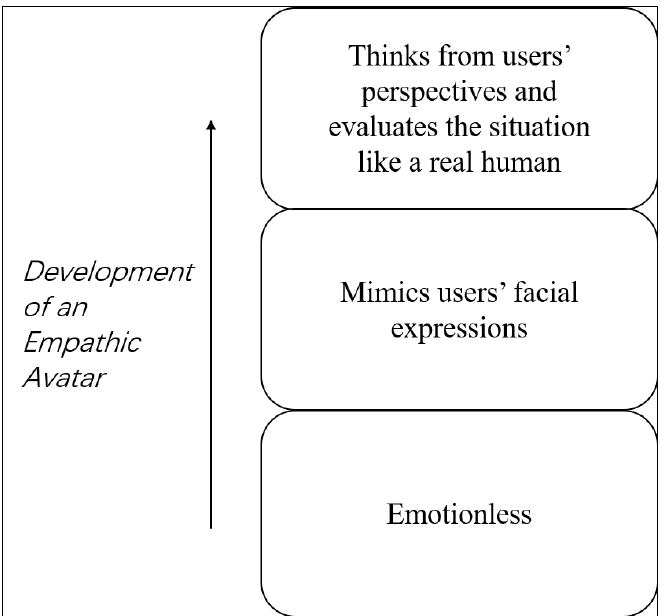
Figure 5. Three modes of Diana following a hierarchical model of